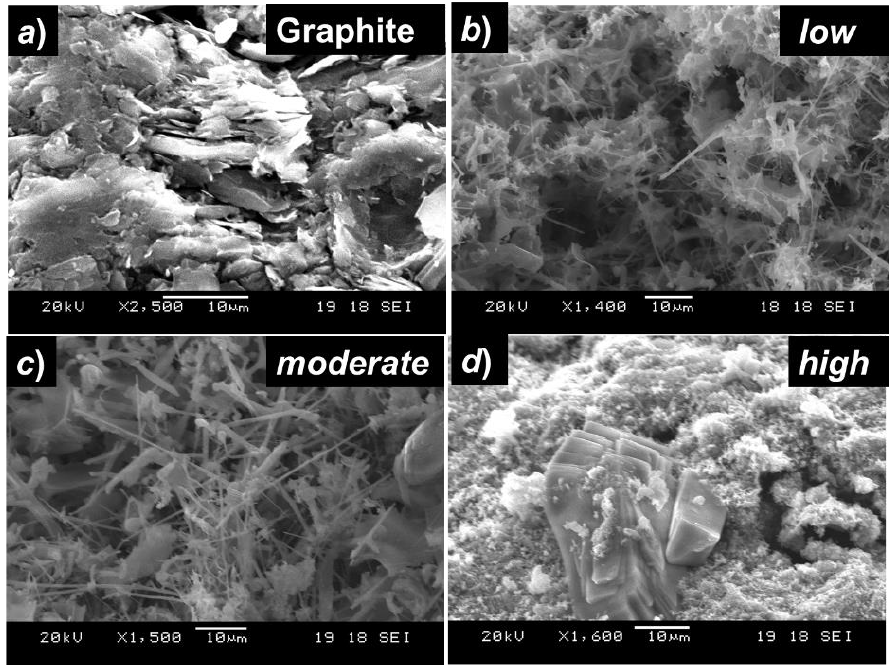
Figure 3. SEM image of the electrochemically deposited Si films on graphite substrates ( a ) surface of the graphite substrate before electrodeposition, ( b ) Si-films obtained with applying reduction potential at the graphite-substrate set as low potential vs. Mo-RE. ( c ) Si-films obtained at moderate potential , ( d ) Si-films obtained at high potential .